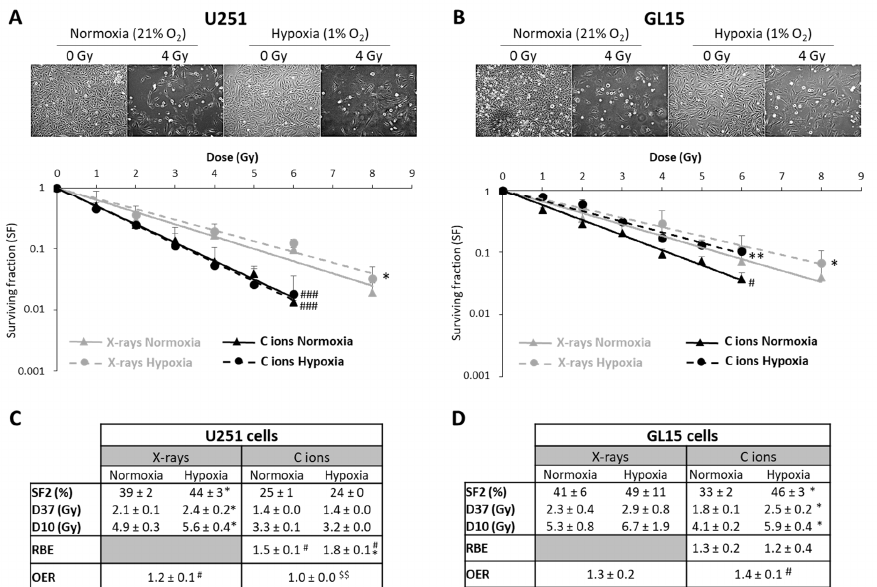
Figure 3. Comparison of survival after exposure of glioblastoma cells to X-ray and carbon ion irradiation in normoxia and hypoxia. ( A and B ) Representative photographs of the cell morphology observed 72 h after carbon ion irradiation in normoxia or hypoxia (4 Gy, C ions 28 keV/µm) for U251 cells (A-top) and GL15 cells (B-top). Survival curves from clonogenic assays performed under normoxic (21% O 2 ) or hypoxic conditions (1% O 2 ) after X-rays or carbon ions (28 keV/µm) for U251 cells (A-bottom) and GL15 cells (B-bottom). Fisher’s LSD post-hoc test after significant two-way ANOVA (group and dose effects): * p < 0.05, ** p < 0.01 vs. normoxia for X-rays or CIRT; # p < 0.05, ### p < 0.0001 vs. X-rays in normoxia or hypoxia; ( C ) Quantification of radiobiological parameters obtained after X-rays or CIRT in U251 cells and ( D ) GL15 cells grown under normoxic or hypoxic conditions. SF2, D37, and D10: * p < 0.05 vs. normoxia (Fisher’s LSD post-hoc test after a significant one-way ANOVA). RBE: # p < 0.05 vs. theoretical value = 1 (univariate t -test) and * p < 0.05 vs. normoxia (Student’s t -test). OER: # p < 0.05 vs. theoretical value = 1 (univariate t -test) and $$ p < 0.01 vs. X-rays (Student’s t -test). All data in the figure are presented as mean ± SD of 3 different experiments performed in triplicate ( n =